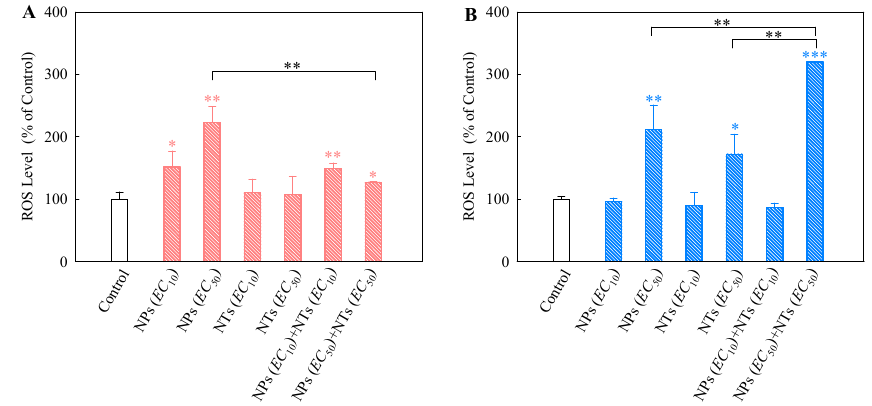
Figure 6. Relative levels of reactive oxygen species (ROS) detected using 2 ′ ,7 ′ -dichlorodihydrofluorescein diacetate (DCFH-DA) staining in Scenedesmus obliquus ( A ) and Chlorella pyrenoidosa ( B ) exposed to single TiO 2 NPs and TiO 2 NTs at each EC 10 or EC 50 value, as well as TiO 2 NPs + NTs at the EC 10 or EC 50 ratios. Statistical significance versus control group: * p < 0.05, ** p < 0.01, and *** p < 0.001.